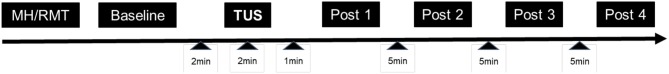
Study Design. The experimental visit lasted between 70 and 100 min. MH, acquisition of the motor hotspot; RMT, acquisition of resting motor threshold.